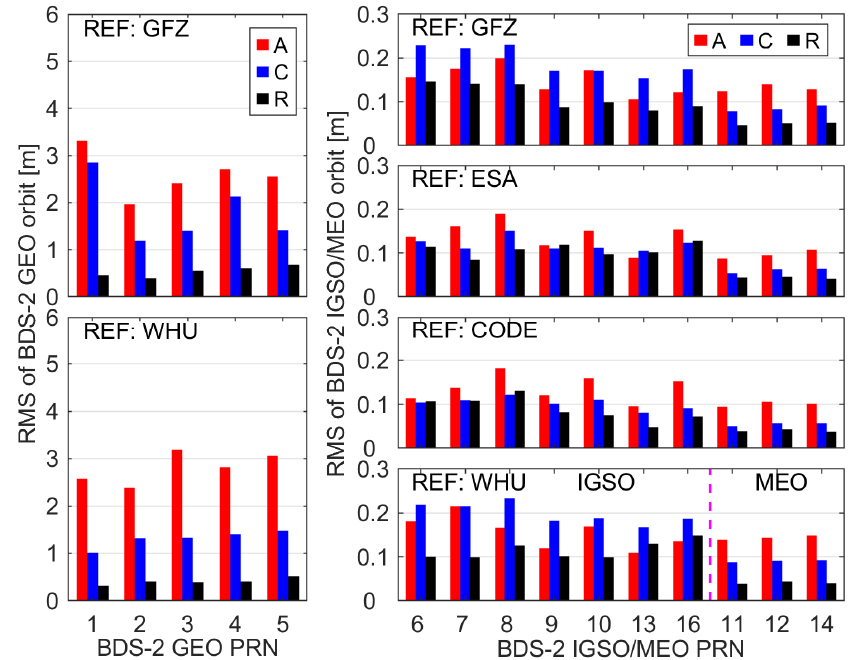
Figure 3. RMS of BDS-2 ISC orbits based on B1I/B3I compared with different MGEX ACs in the along-track (A), cross-track (C), and radial (R) directions, respectively.